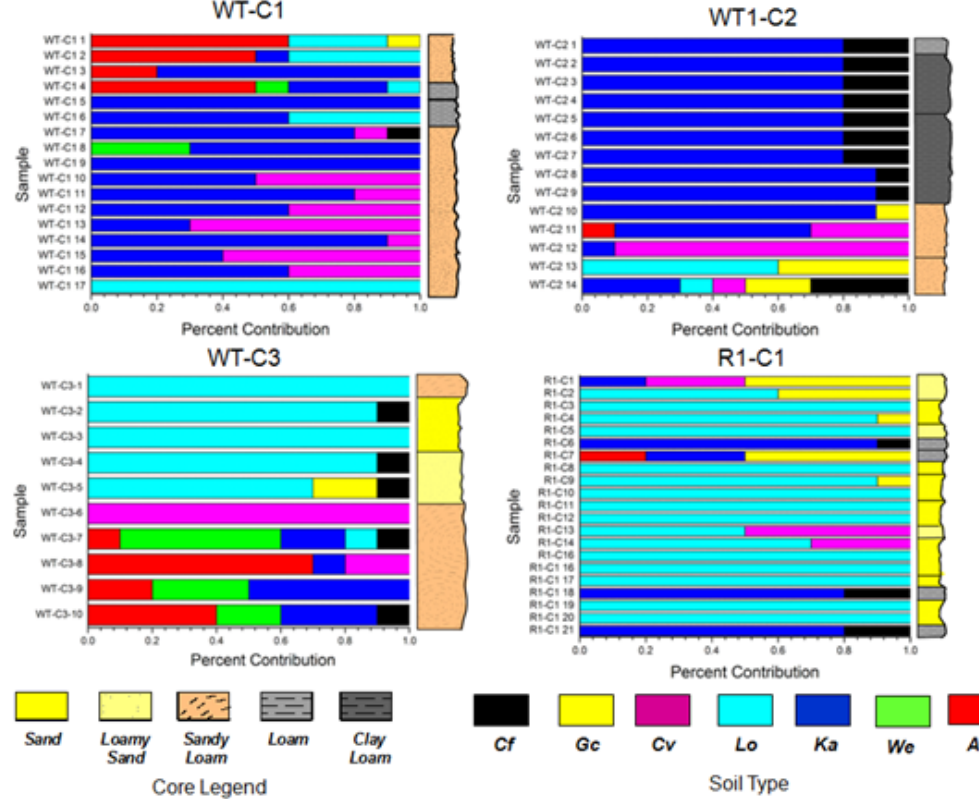
Fig. 7. Relative percent of sediment derived from specific soil types within the catchment. Av – Avalon, Cf – Cartref, Cv – Clovelly, Gc – Glencoe, Ka – Katspruit, Lo – Longlands, We -